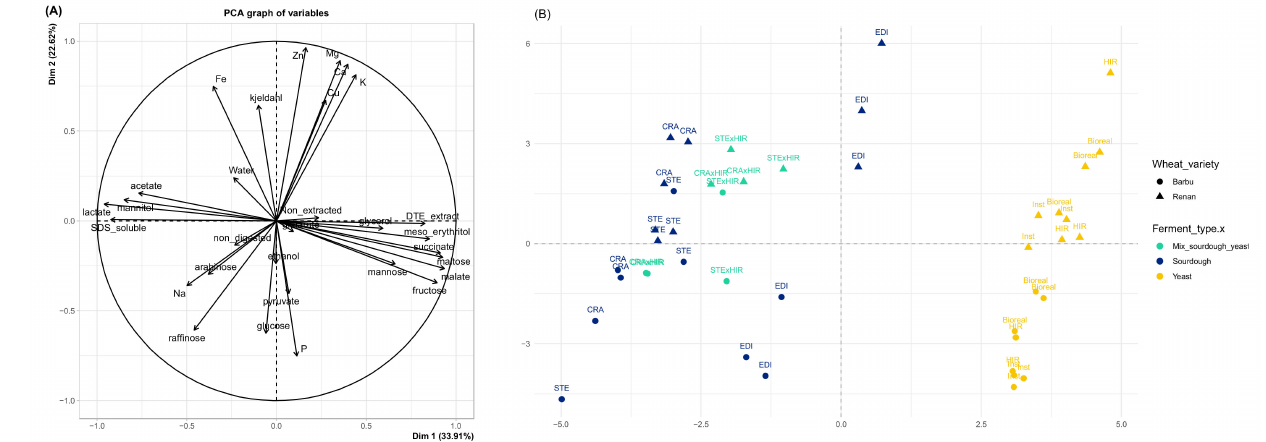
Figure 4. Principal component analysis with ( A ) graph of all quantitative variables according to leavening agent—bread sugars, polyols, organics acids and alcohols contents, bread protein fractions proportions, bread protein total content, non-digested bread protein proportion, and bread minerals contents—and ( B ) plot according to the 8 leavening agents (sourdoughs CRA, EDI, and STE, mixed sourdough/yeast CRA*HIR and STE*HIR, and commercial yeasts Bioreal, HIR, and Inst) and the 2 wheat varieties (Barbu, Renan). (“CRA”, “EDI”, and “STE” referr, respectively, to the bakers Collectif Cravirolla, Edith Brissiaud, and St é phane, and “HIR”, “Bioreal”, and “Inst” refer, respectively, to